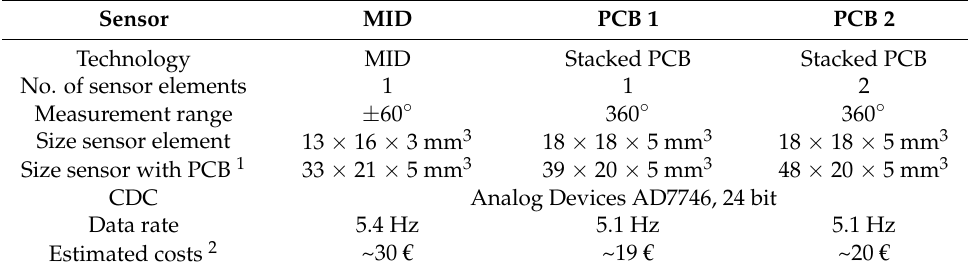
Table 3. Fluidic